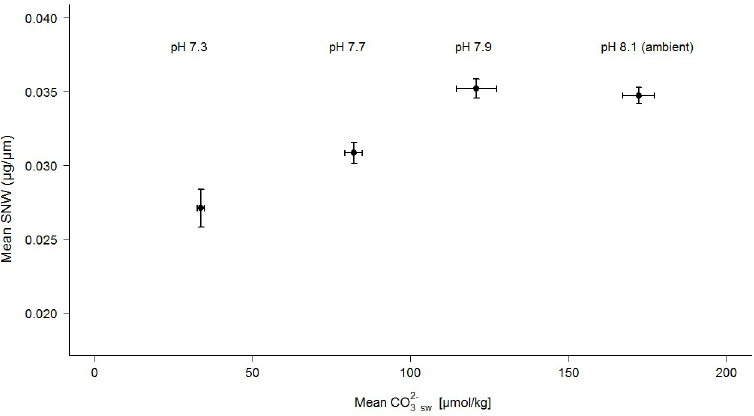
Fig 4. Mean values ( ± standard error) of carbonate ions concentration in seawater and size-normalized weight (SNW) for Elphidium williamsoni cultured at different pH conditions.